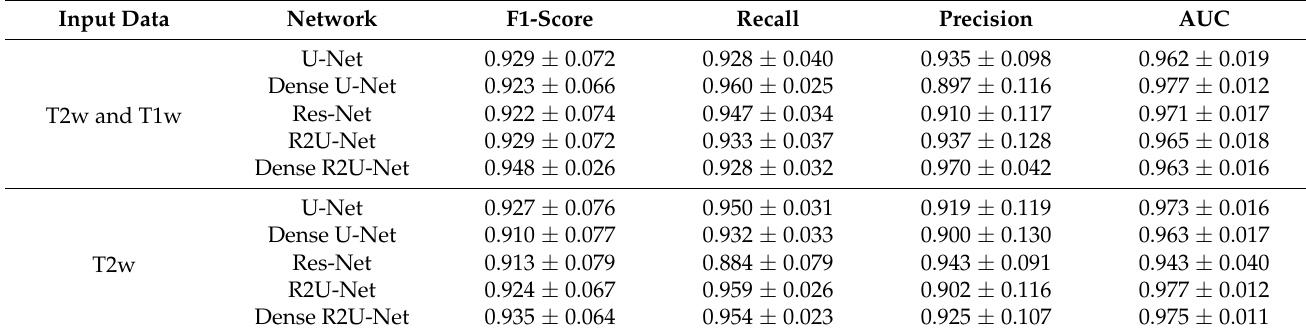
Table 2. Performance metrics (mean ± SD) of PDX tumor segmentation for different network models relative to STAPLE map. Input